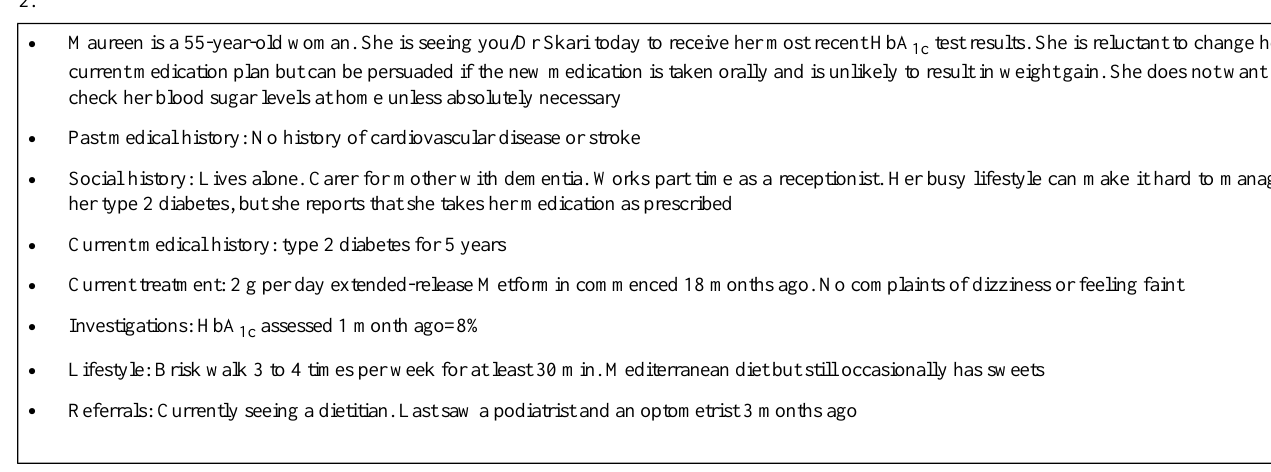
Focus Groups With People With